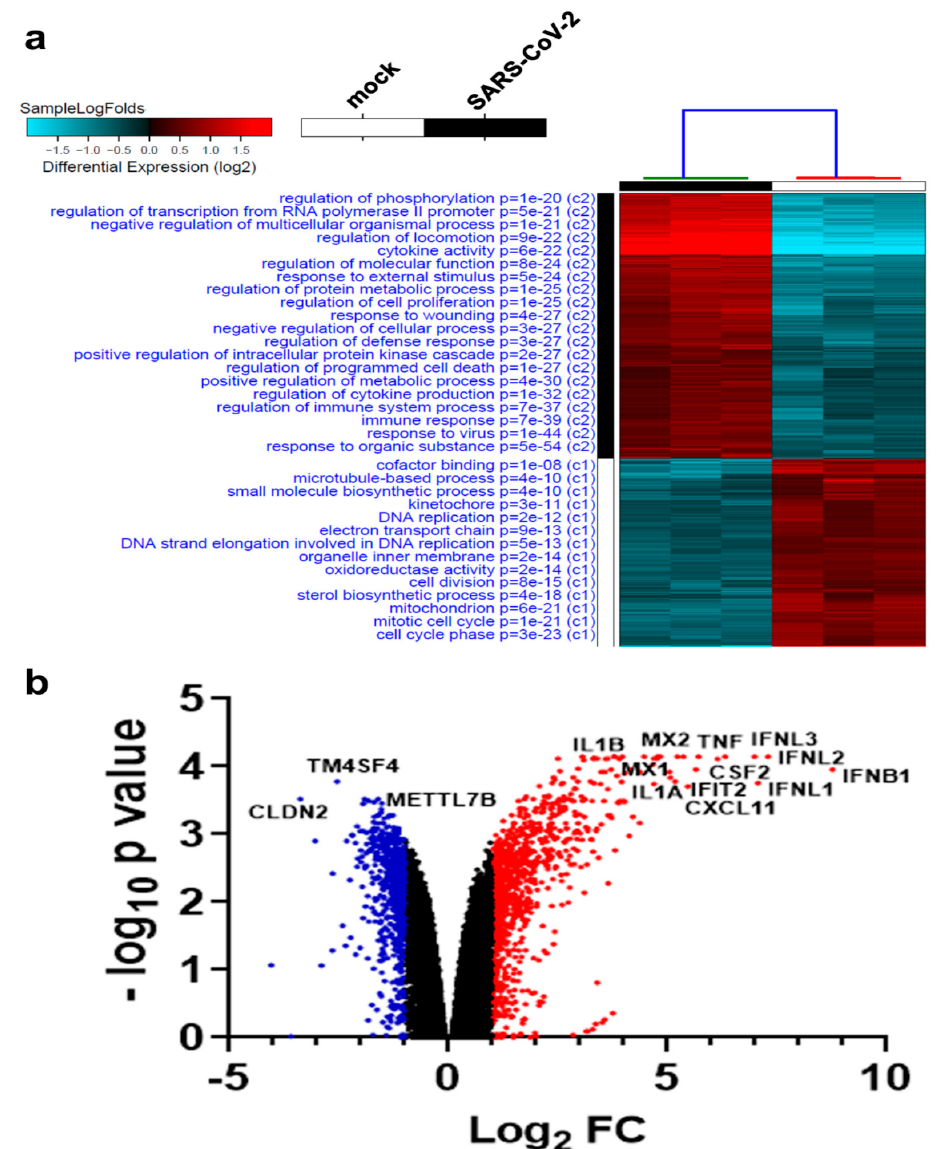
(scatterplot) that shows statistical significance (-log10 p value; Y -axis) versus magnitude of change (log2 fold change; X -axis) is depicted in Figure 1b, with selected genes being displayed. The red colors (right) and blue colors (left) represent genes with significantly upregulated or downregulated versus mock-infected cells, respectively (Figure 1b).